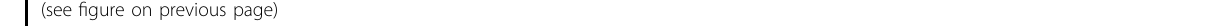
synthesis activity with acetyl-CoA as the substrate to yield AcAcCoA and coenzyme A at pH 8.1 39 . A two-substrate steady-state kinetic assay con fi rmed that the addition of FadA led to the consumption of acetyl-CoA in solution (Fig. 5b), suggesting that FadA may function as an acetyl- CoA acetyltransferase. Consistent with this fi nding,